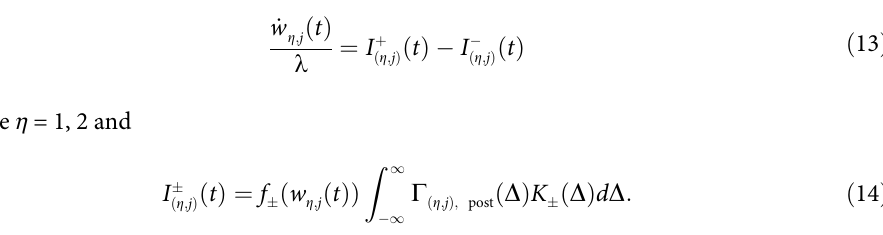
Fig 2. The STDP rules. The temporal kernels, K ( Δ t ) = K + ( Δ t ) − K for ( a ) The asymmetric learning rule, Eq (11) with τ − = 50ms. ( b ) The symmetric learning rule, Eq (12) with τ + = 20ms. Different values of τ + in (a) and τ − in (b) are depicted by color as shown in the legend.